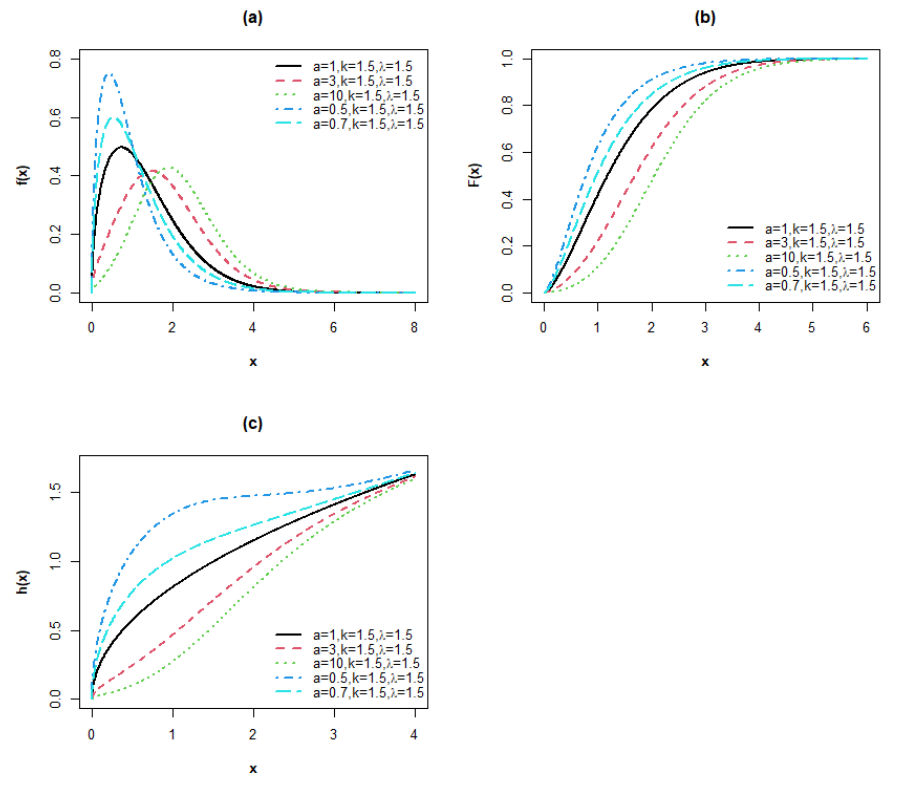
Figure 3. Plots of the ( a ) pdf, ( b ) cdf and ( c ) hrf for the MPoW model.